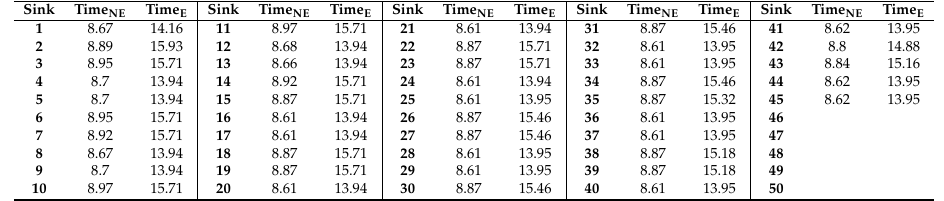
Table A3. Scenario 3: transmission times (in s) for each sink all over the transmission line. (Distance between poles is equal to 50 m, κ = 12, η = 2, NE means no encryption, E means encryption.)